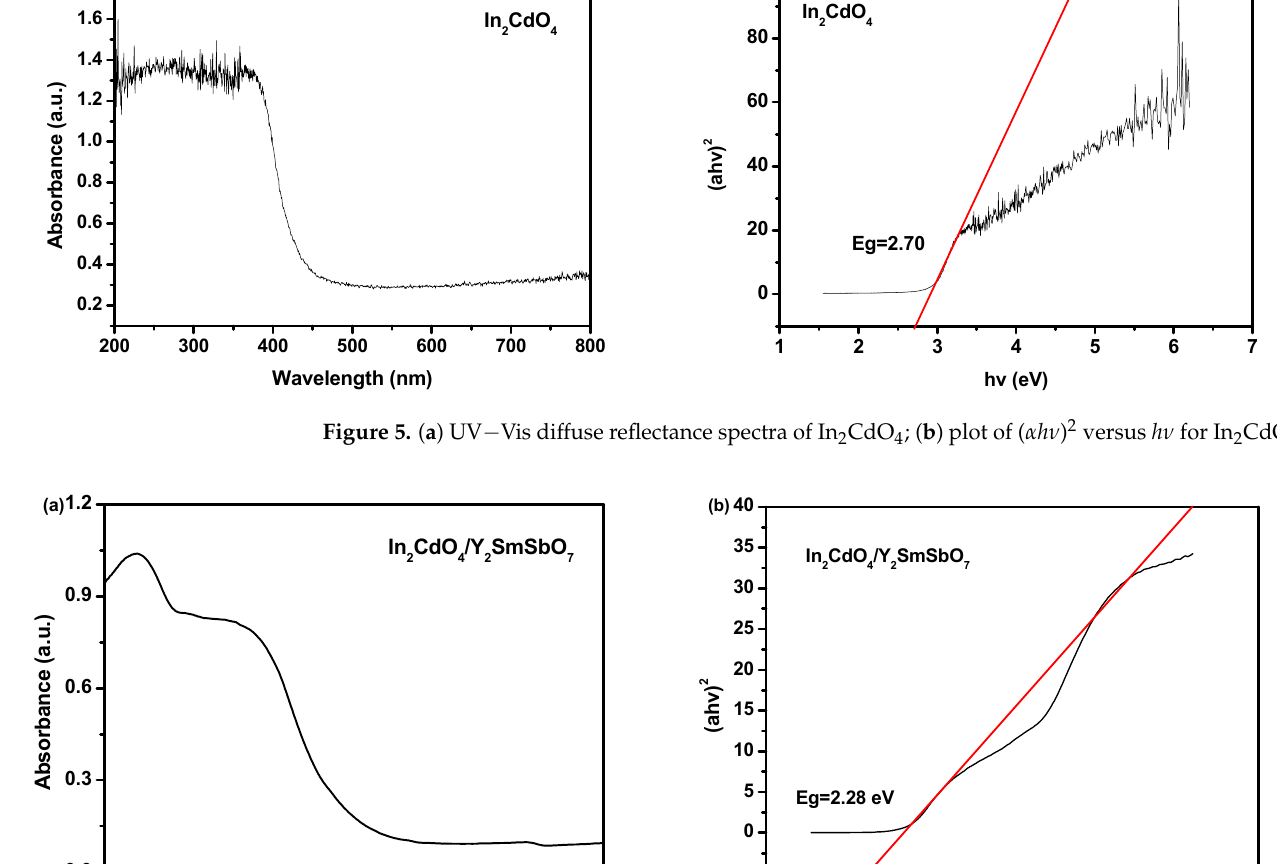
Figure 4. ( a ) UV − Vis di ff use re fl ectance spectra of Y 2 SmSbO 7 ; ( b ) plot of ( α h ν ) 2 versus h ν for Y 2 SmSbO 7 .